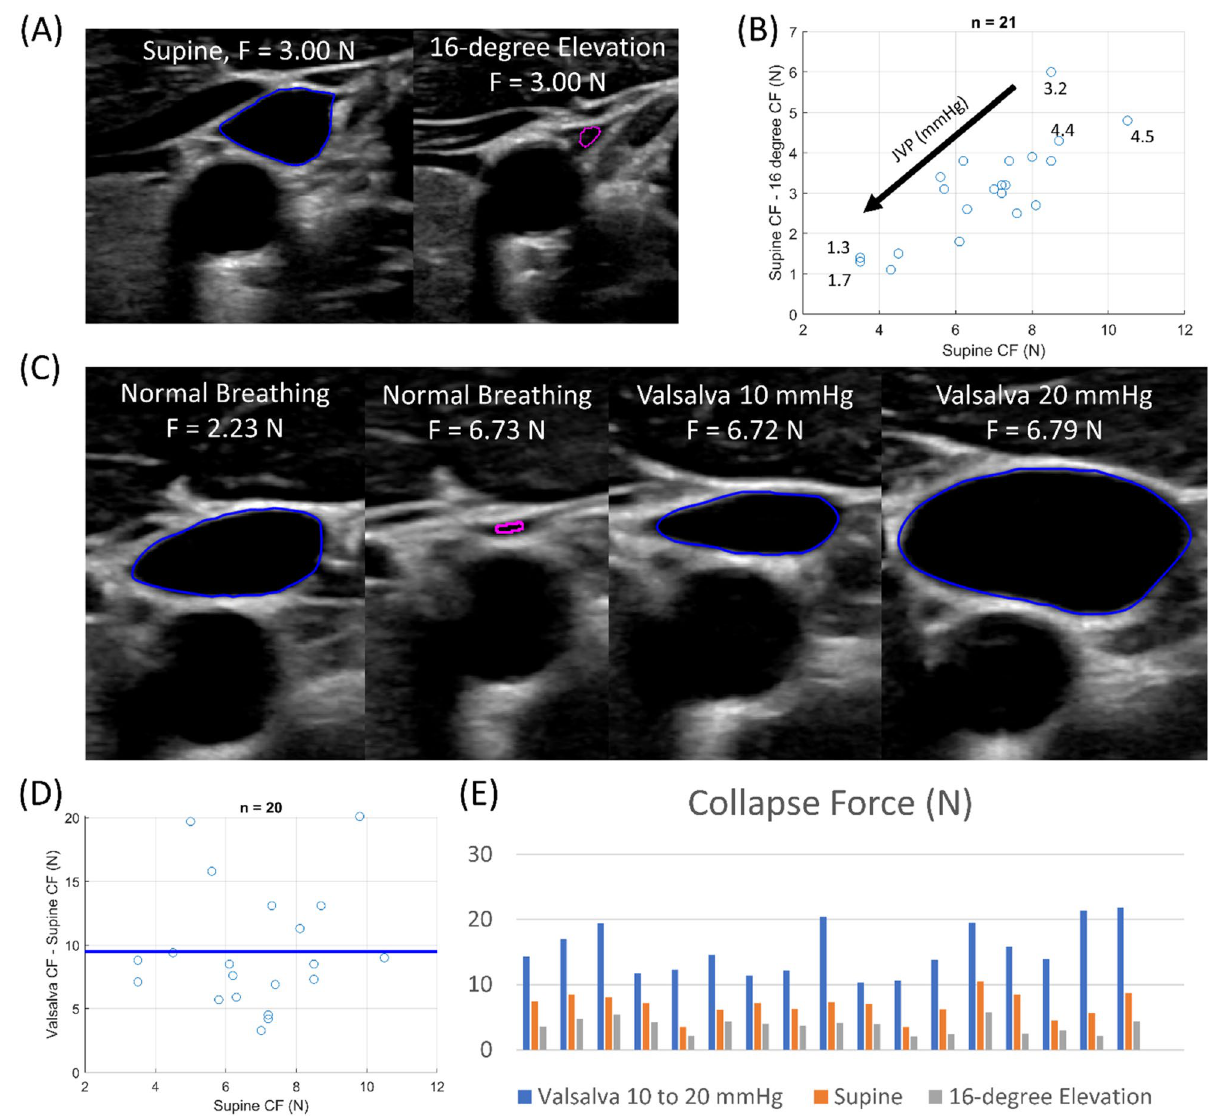
collapse. ( B ) Differences between Supine CF and 16° CF in individual subjects. The solid black line signifies the expected effect on collapse force if only hydrostatic effect was present and our linear regression could perfectly predict collapse force from a perfect venous pressure measurement. ( C ) Effects of Valsalva maneuver on increasing IJV area while under force in subject 20. The blue outlines the IJV segmentation while the magenta dot signifies an IJV near collapse. ( D ) Difference between Valsalva collapse force and supine collapse force in the same subjects. The solid blue line represents the mean difference. ( E ) Collapse forces when subjects measure between 10 and 20 mmHg of airway pressure by the Valsalva maneuver compared to collapse forces when subjects are breathing normally while supine and while elevated by